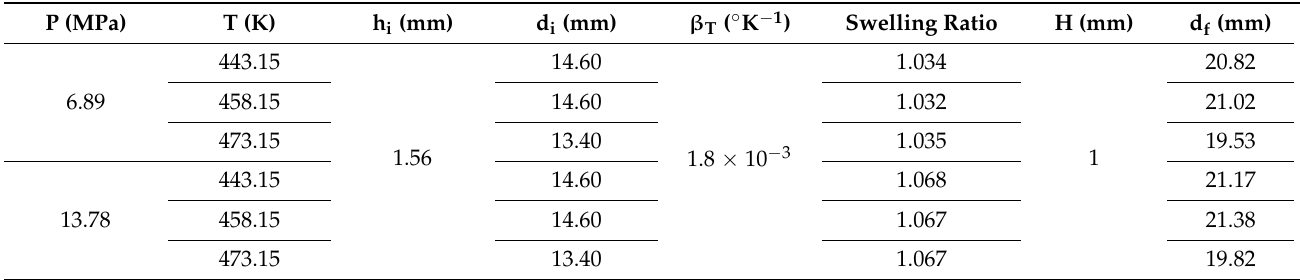
Table 12. Polymer discs dimensions after and during testing with SC ‐ CO 2